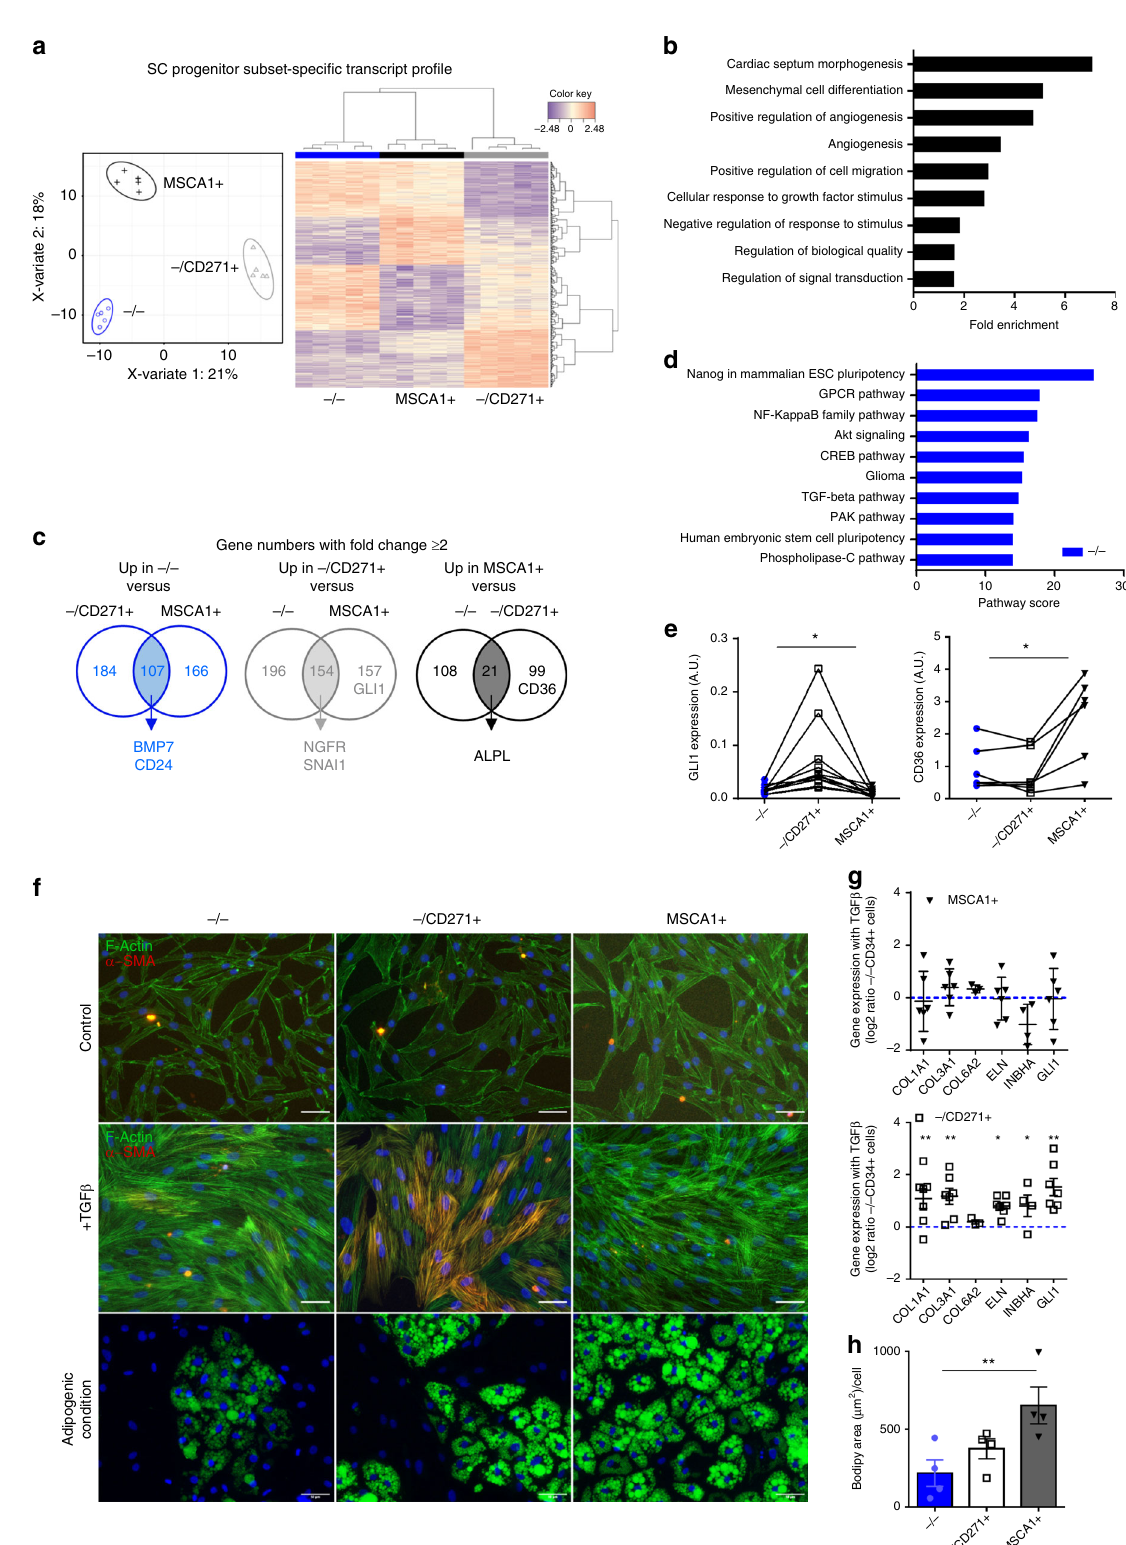
AT location-speci fi c transcript pro fi les independently of subsets (Fig. 6a), enriched in pathways related to development (Fig. 6b), highlighting transcription factors with marked fat depot-speci fi c expression (Fig. 6c). Gene expression comparisons between VS and SC progenitor subsets (two or more fold changes) highlighted 349 common transcripts speci fi cally upregulated in VS progenitor